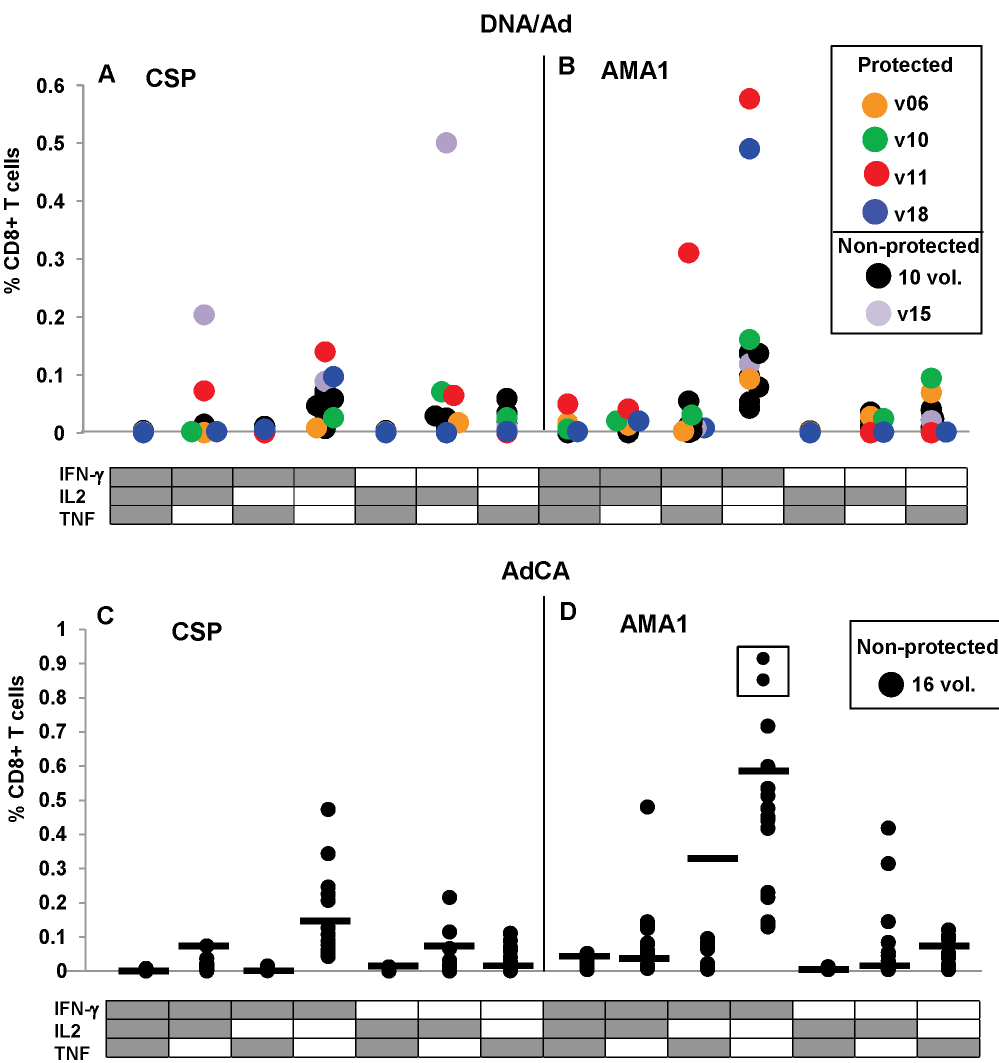
Figure 5. DNA/Ad and AdCA CD8 + T cell antigen-specific activities are predominantly monofunctional with lower polyfunctional responses. Monofunctional and polyfunctional CD8 + T cell activities to CSP and AMA1 after DNA/Ad (Panels A and B) and AdCA (Panels C and D) immunization are shown as color-coded filled circles that represent the percent of CD8 + T cells containing cytokine(s). Black horizontal bar denotes highest activities in DNA/Ad compared with AdCA activities. Activities to individual CSP and AMA1 peptide pools are shown in Figures S1 and S2. Panel A: DNA/Ad CSP: IFN- c monofunctional activities of protected v11 and v18 were higher (v11, 0.14%; v18, 0.1%) than the two positive non- protected volunteers (v03, 0.07%; v15, 0.09%). Non-protected v15 developed the highest IFN- c /IL2 polyfunctional (0.20%) and IL2 monofunctional (0.5%) activities. Protected v11 developed positive IFN- c /IL2 polyfunctional (0.07%) and IL2 monofunctional (0.06%) activities. Panel B: DNA/Ad AMA1: IFN- c monofunctional activities of protected v10, v11 and v18 (v10, 0.16%; v11, 0.58%, v18, 0.49%) were higher than the eight non-protected volunteers (range 0.05–0.14%). Non-protected v17 and protected v10 also developed lower TNF- a monofunctional (0.07%, 0.09%) activity; v11 also developed IFN- c /TNF- a polyfunctional (0.31%) activity and lower IFN- c /IL2 polyfunctional (0.04%), and IFN- c /IL2/TNF- a polyfunctional (0.05%) activities. Panel C: AdCA CSP: 11 volunteers developed IFN- c monofunctional activities (0.05%–0.48%), of whom one volunteer developed IFN- c /IL2 polyfunctional, three developed IL2 monofunctional and two additional volunteers also developed IL2 monofunctional activities. Four volunteers had higher IFN- c and two volunteers had higher IL2 monofunctional activities than protected volunteers in DNA/Ad. Panel D: AdCA AMA1: all 16 volunteers developed positive IFN- c monofunctional – boxed volunteers are above scale (1.60% and 1.79% respectively), of whom nine developed lower IFN- c /IL2 polyfunctional or IFN- c /TNF- a polyfunctional activities; three volunteers developed IL2 monofunctional and TNF- a monofunctional activities. Four volunteers had higher IFN- c monofunctional and eight volunteers had higher IFN- c /IL2 polyfunctional activities than protected volunteers in the DNA/Ad trial.